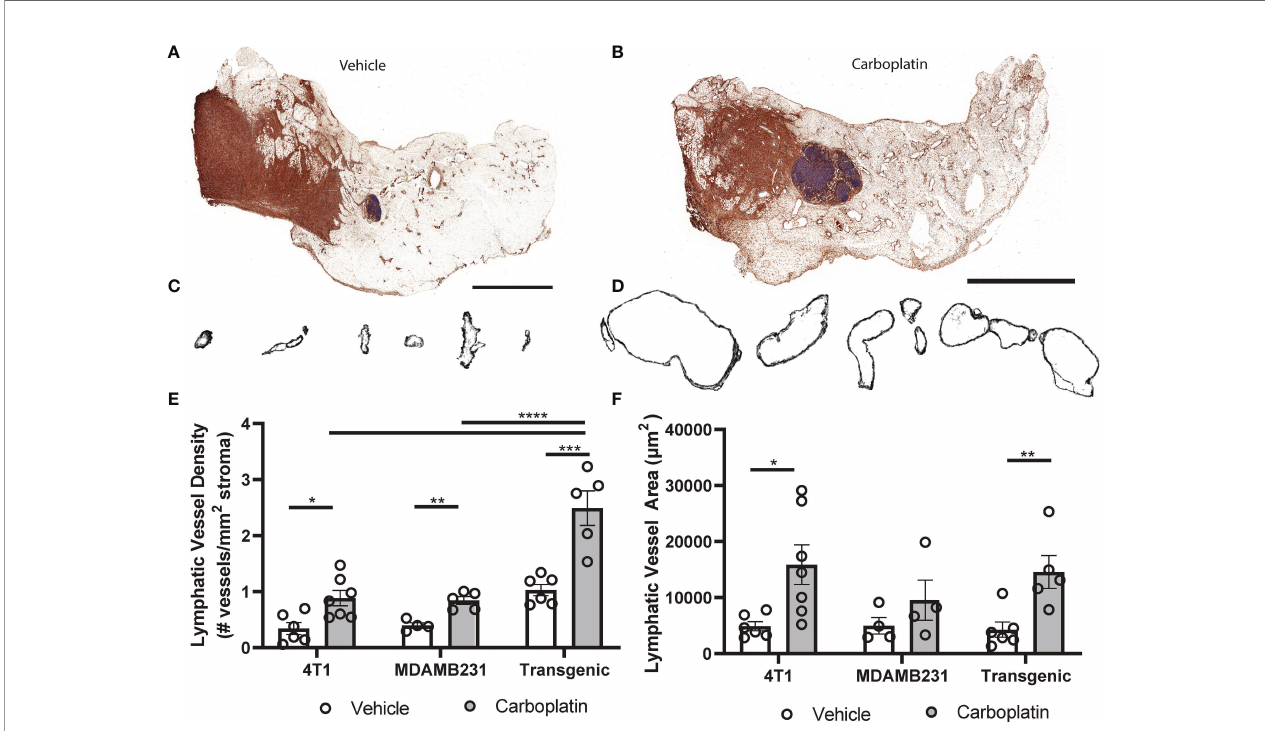
FIGURE 4 | Platinum agents induce lymphangiogenesis in the tumor stroma (A) Representative tumor-bearing mammary fat pad with podoplanin (brown) and hematoxylin (blue) from vehicle-treated transgenic Kras G120D p53 fl / fl p110a myr mice. (B) Representative whole tumor-bearing mammary fat pad from carboplatin- treated transgenic mice. (C) Representative individual lymphatic vessel cross-sections from (A) . (D) Isolated lymphatic vessels from (B) . (E) Lymphatic vessel density (lymphatic vessels per stromal area) in tumor-bearing mammary fat pads in 3 orthotopic mouse models of breast cancer (syngeneic 4T1 N = 12, transgenic Kras G120D p53 fl / fl p110a myr N = 11, and xenografted MDA-MB-231 N = 9). (F) Average area of individual lymphatic vessels (µm 2 ) in mouse models of breast cancer as described previously. *p < 0.05, **p < 0.01, ***p < 0.001, ****p < 0.0001, each data point represents one